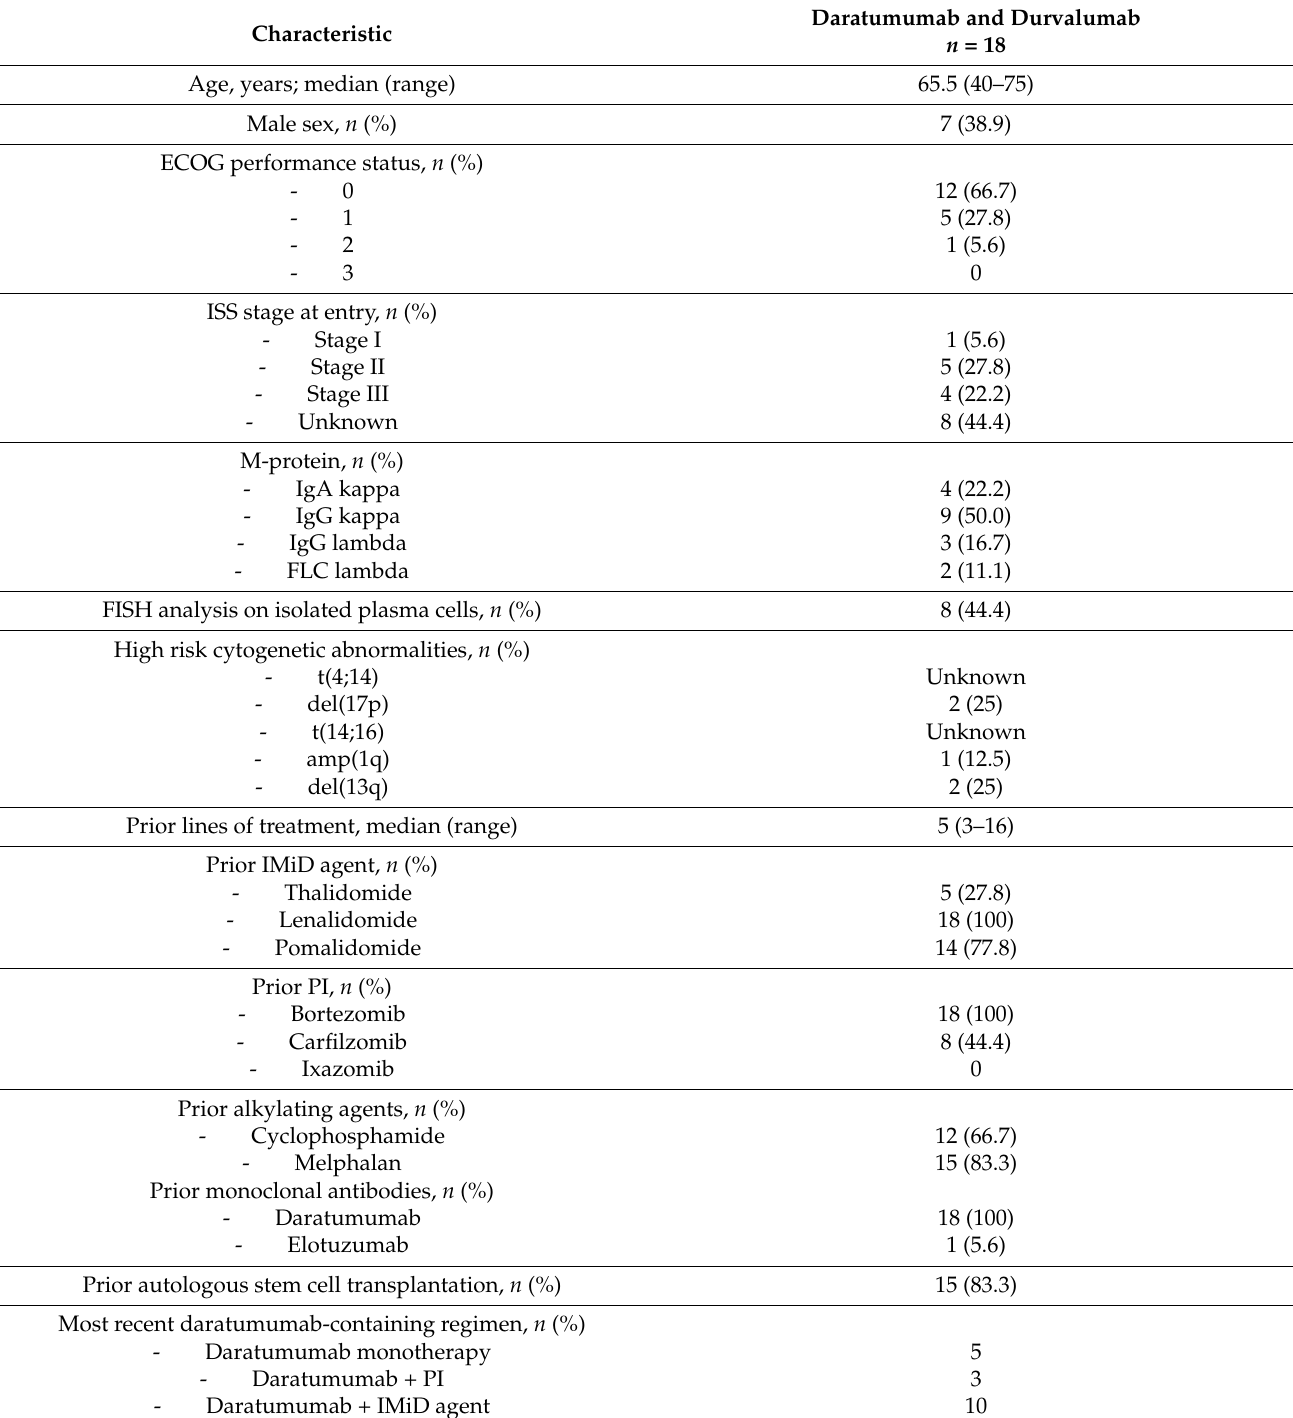
Table 1. Baseline